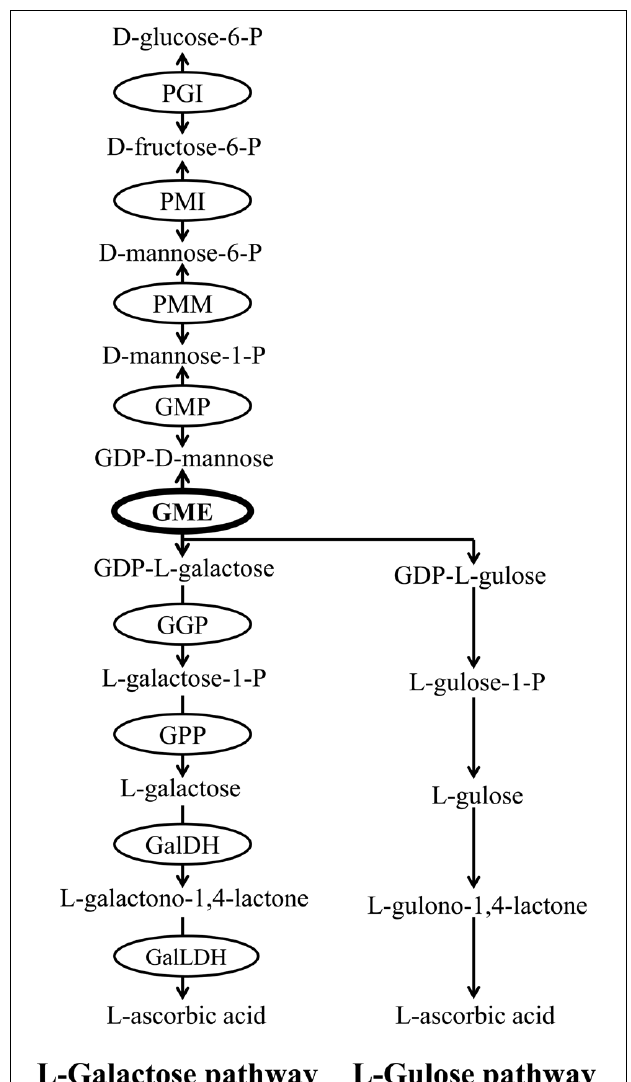
FIGURE 1 | L -galactose pathway and L -gulose pathway of plant AsA biosynthesis. Enzymes (circled) in L -galactose pathway include PGI (glucose-6-phosphate isomerase), PMI (mannose-6-phosphate isomerase), PMM (phosphomannomutase), GMP (GDP-mannose pyrophosphorylase), GME (GDP-mannose-3 (cid:48) ,5 (cid:48) -epimerase), GGP (GDP- L -galactose phosphorylase), GPP ( L -Galactose-1-phosphate phosphatase), GalDH ( L -Galactose dehydrogenase), GalLDH ( L -Galactono-1,4-lactone